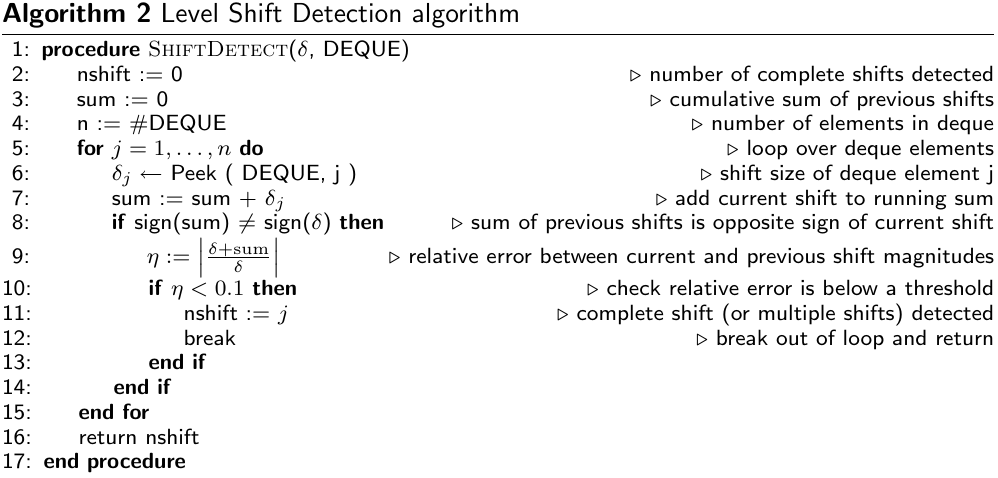
Algorithm 2 Level Shift Detection